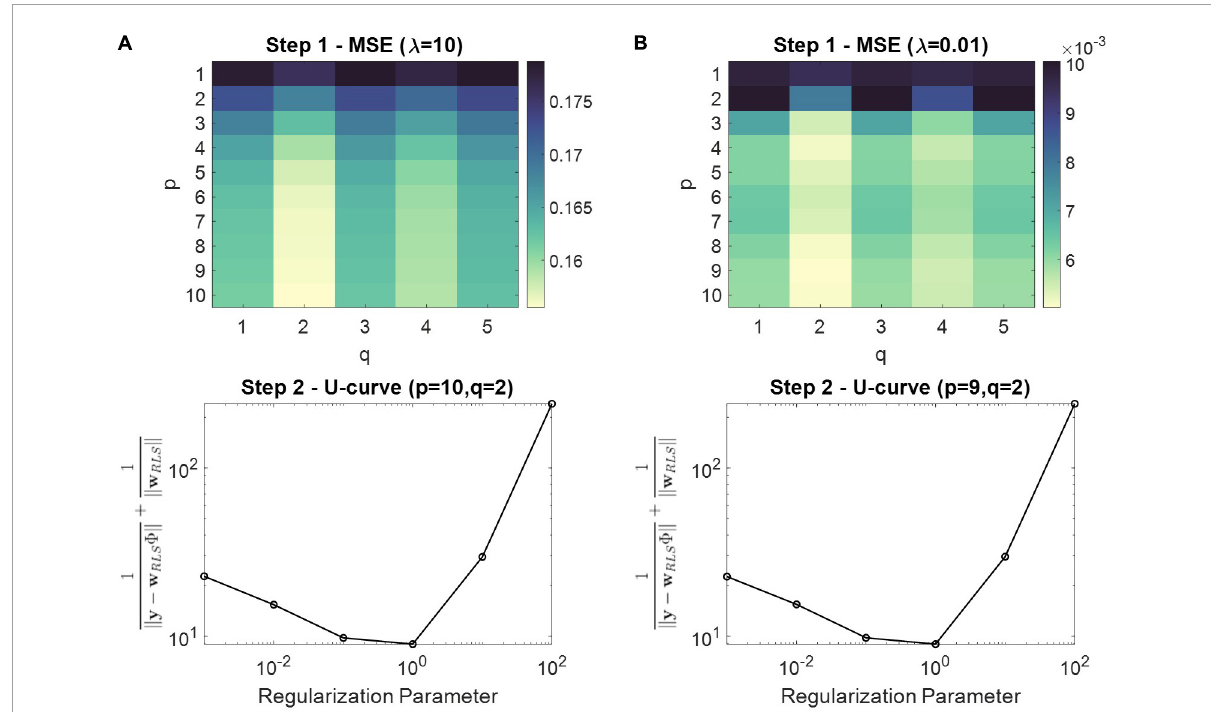
FIGURE3 Two step model order selection procedure for one representative realization of Eq. 31 and simulation set I. (A) The top panel depicts the MSE obtained during step 1 for different p and q values using a regularization parameter of λ = 10 as an initial value. The bottom panel depicts the U-curve from step 2, using the model order that achieved the smallest MSE [i.e., ( p , q ) = ( 10 , 2 ) ] at step 1 (i.e., top panel). The regularization parameter that corresponds to the minimum of the U-curve was selected as optimal (i.e., λ = 1). (B) Similar as (A) , however, the initial regularization parameter at step 1 was set to λ = 0 .